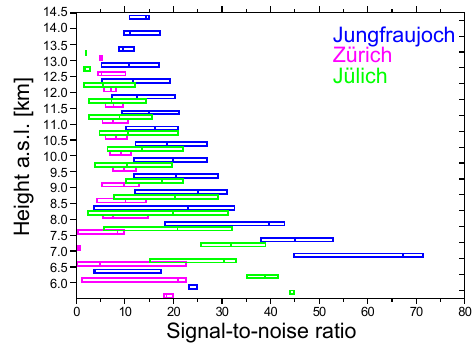
Figure 5. Vertical distribution of the signal-to-noise ratio of the de- tected cirrus clouds for Jungfraujoch, Jülich, and Zürich. The center line of each box plot represents the median. The left and right limits of the box plots mark the 25th and 75th percentiles,